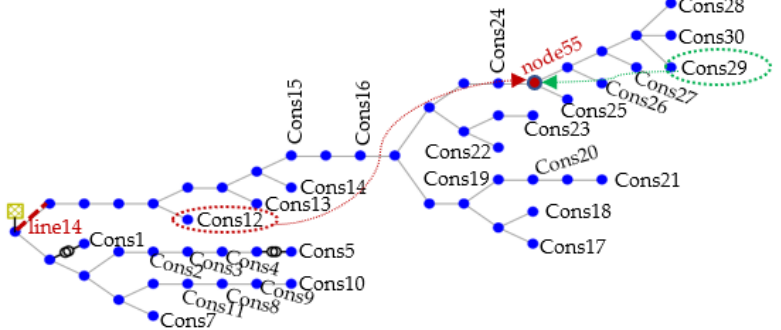
Figure 10. Illustration of the results listed in Table 3.